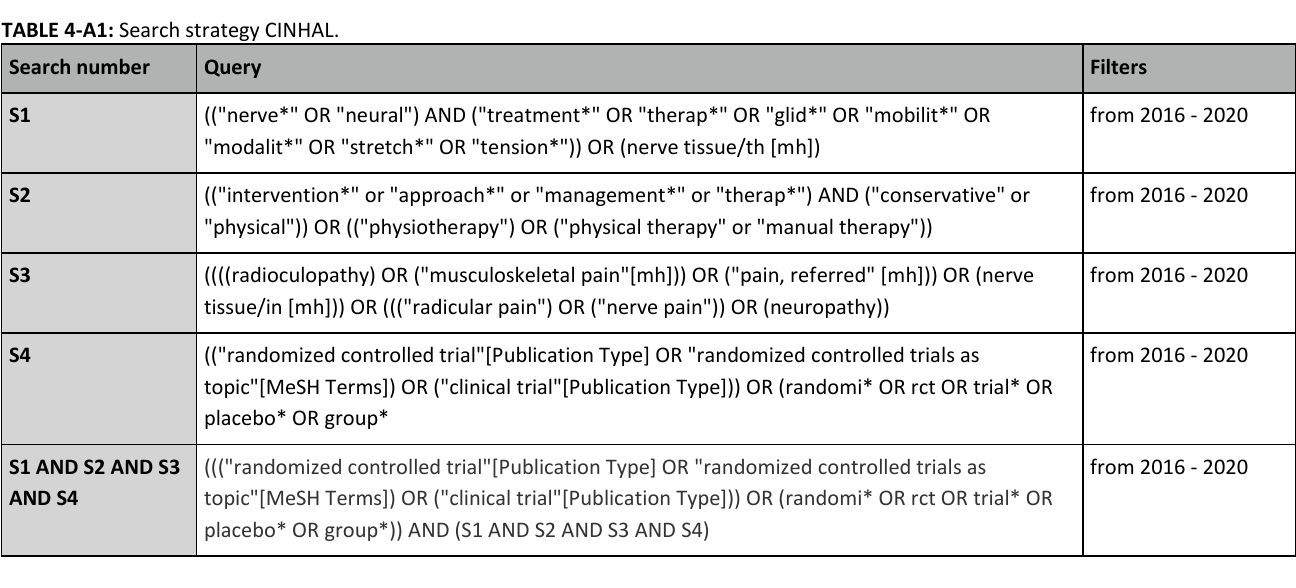
TABLE 5-A1 : Search strategy Science Direct. Query Filters (Nerve OR neural OR radiculopathy OR “radicular pain”) AND (“nerve mobilisation” OR “nerve mobilization”